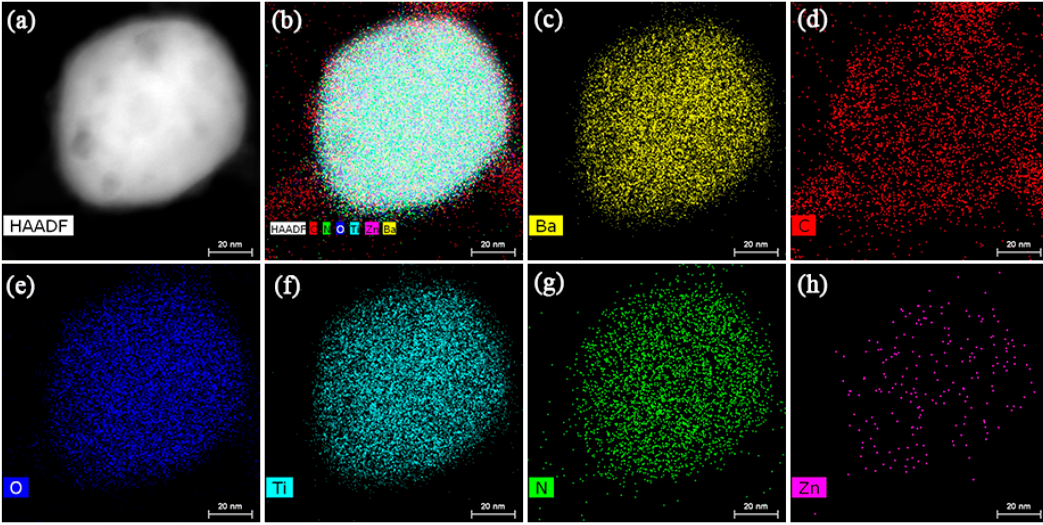
Figure 2. ( a ) STEM images of BT@ZnPc. EDS mapping images of ( b ) all elements, ( c ) Ba, ( d ) C, ( e ) O, ( f ) Ti, ( g ) N, ( h ) Zn. ( f ) Ti, ( g ) N, ( h )